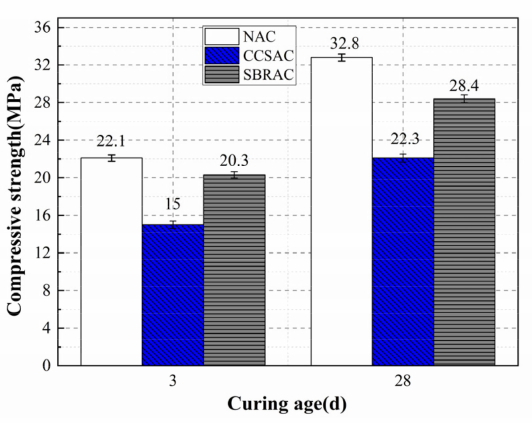
Figure 4. Compressive strength of